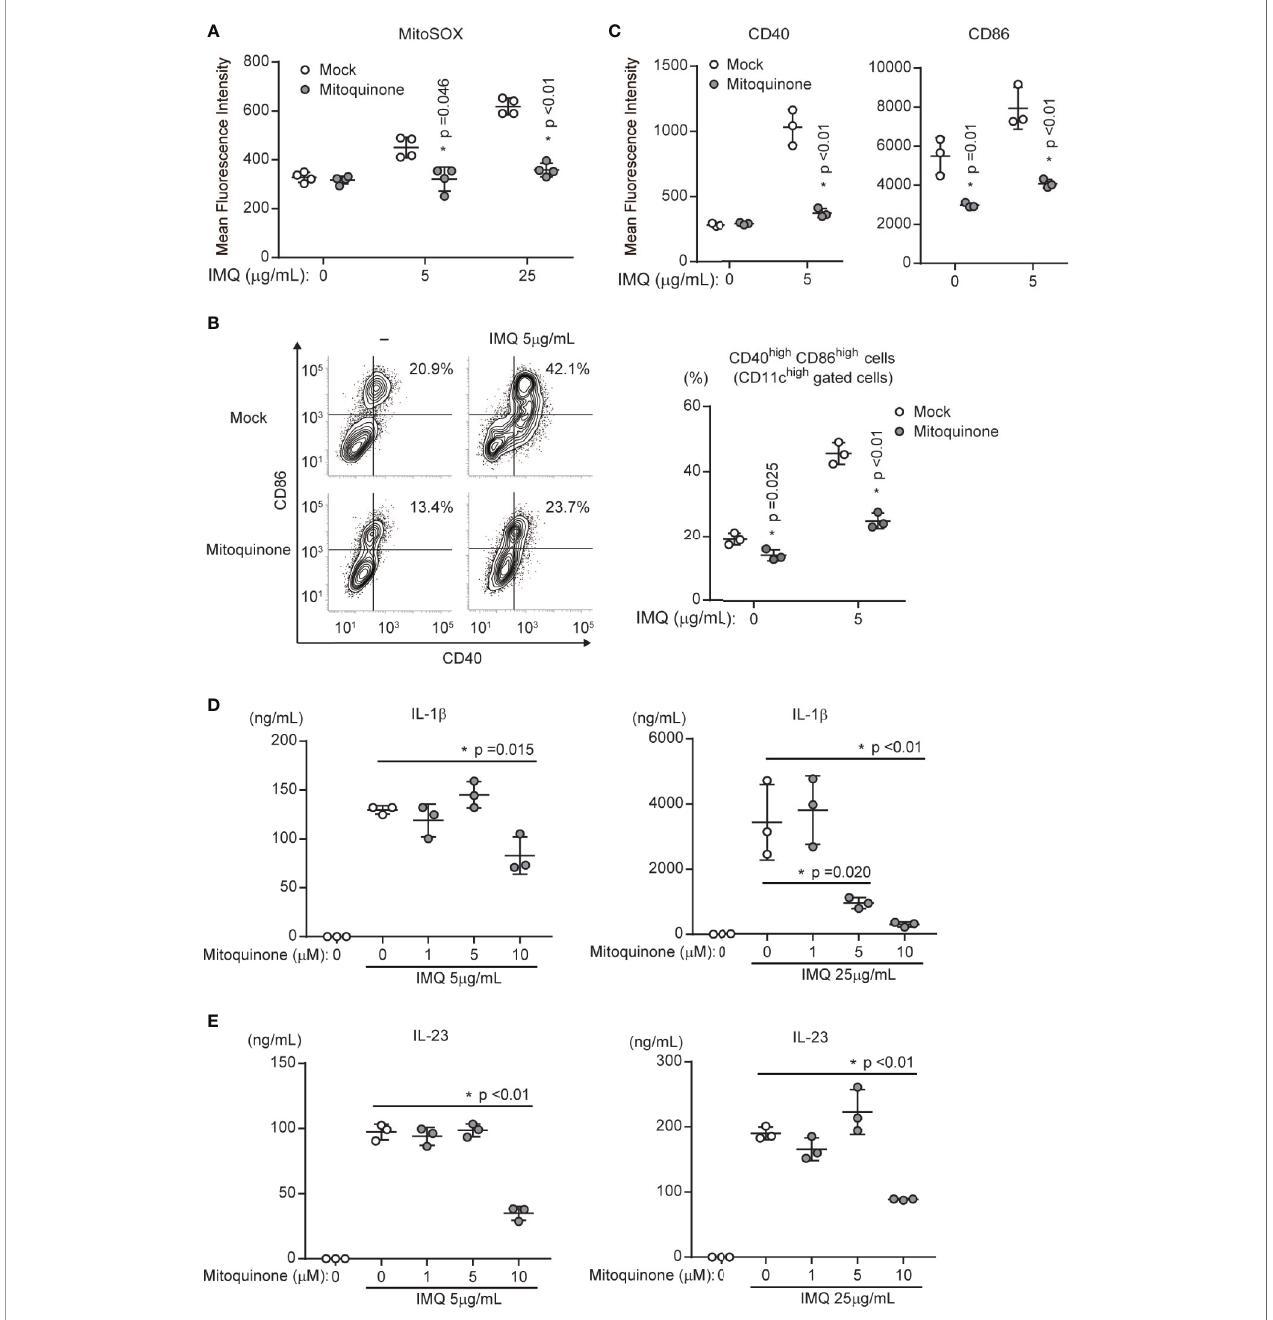
FIGURE 5 | Mitochondrial ROS are required for DC activation by IMQ stimulation. (A) WT DCs in the presence or absence of mitoquinone were stimulated with 5 or 25 m g/mL IMQ and analyzed for the expression of mitochondrial ROS (MitoSOX). Data are shown as means ± SDs (n = 4). (B, C) WT DCs in the presence or absence of mitoquinone were stimulated with IMQ and analyzed to quantify the expression of cell surface markers CD86 and CD40 (C) . Numbers in the top right corners indicate the percentages of CD86 + CD40 + cells ( B , left). Pooled results from three independent experiments are shown ( B , right). Data are shown as means ± SDs of triplicate samples. (D, E) Cytokine production was compared among WT DCs exposed to mock treatment or mitoquinone. Cells were stimulated with 5 or 25 m g/mL IMQ for 24 h in the presence or absence of inhibitors. Data indicate the levels of IL-1 b (D) and IL-23 (E) in cell culture supernatants (means ± SDs of triplicate wells). Data are shown as means ± SDs. *p < 0.05 versus mock treatment. Data are representative of three independent